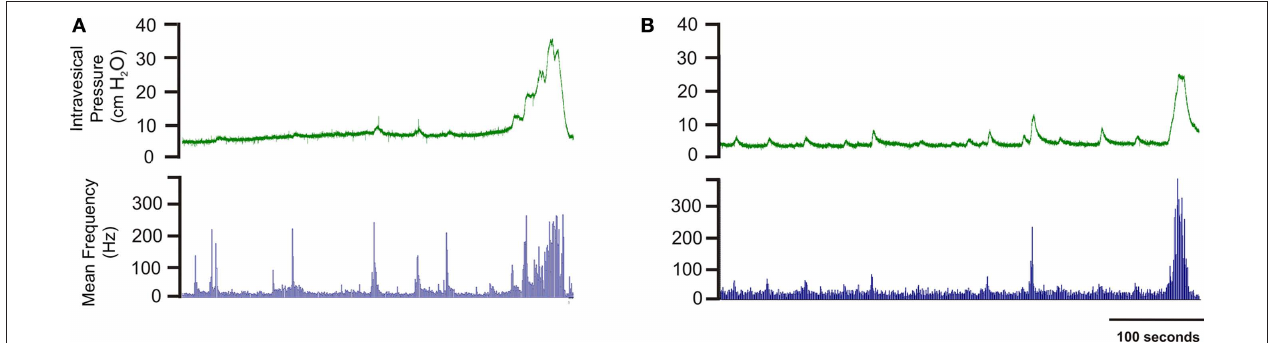
phase. The phasic intravesical pressure components were associated with bursts of afferent discharge. Phasic bursts of afferent activity were observed in all recordings regardless of pressure fluctuations.